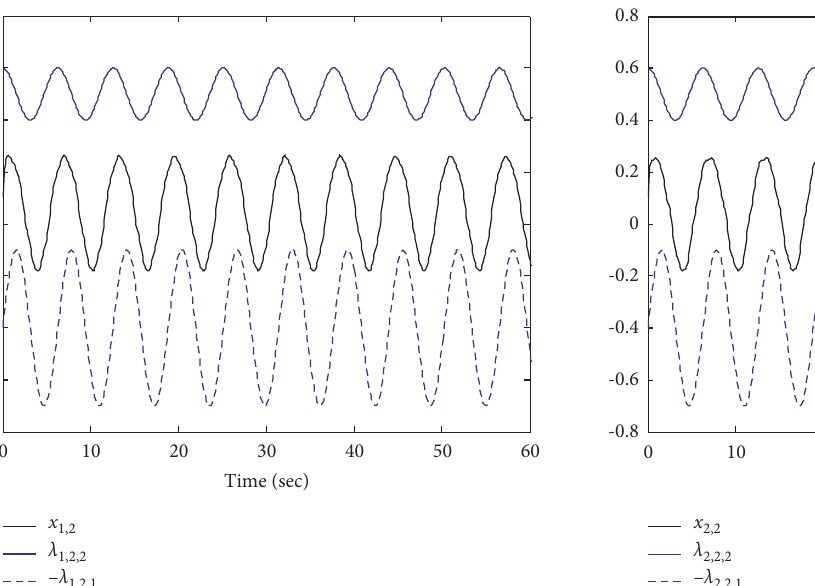
Figure 6: Trajectories of state variable x